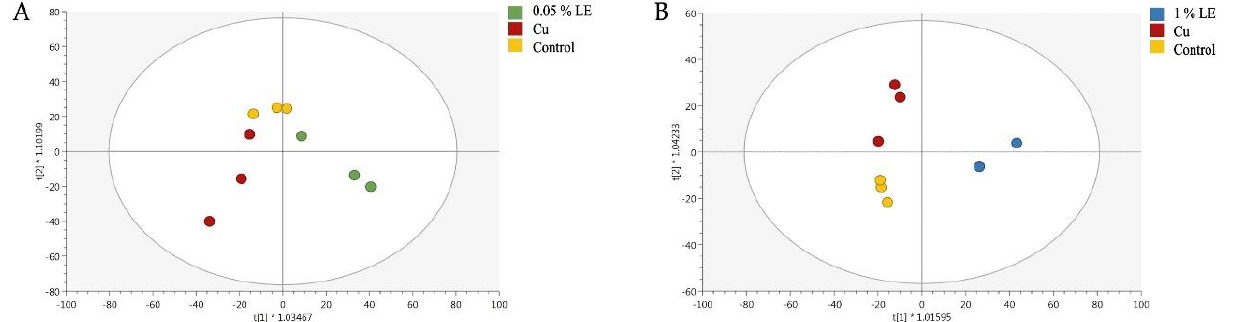
Figure 4. Orthogonal projection to latent structures discriminant analysis (OPLS-DA) supervised of maize plants treated with 0.05% LE ( A ) and 1.00% LE ( B ) treatments. The metabolomic dataset produced through UHPLC-ESI/QTOF-MS was Pareto scaled and then used for the multivariate OPLS-DA modeling (R 2 Y = 0.71 Q 2 Y = 0.41 (A) and R 2 Y = 0.88 Q 2 Y = 0.47 (B)).